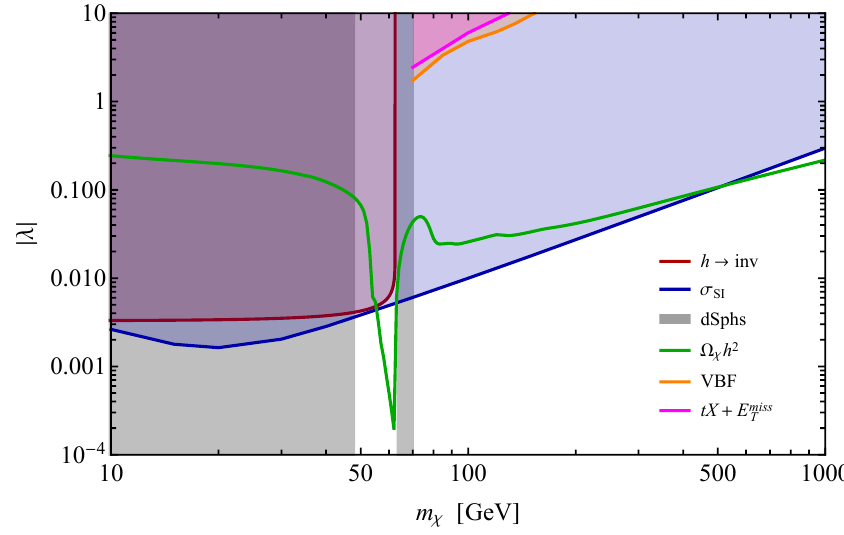
Figure 9 . Constraints in the m χ – | λ | plane for the marginal Higgs portal model. Apart from the fact that in the parameter space below the green curve the Universe is overclosed, the meaning and colour coding of the shown constraints resemble those of figure